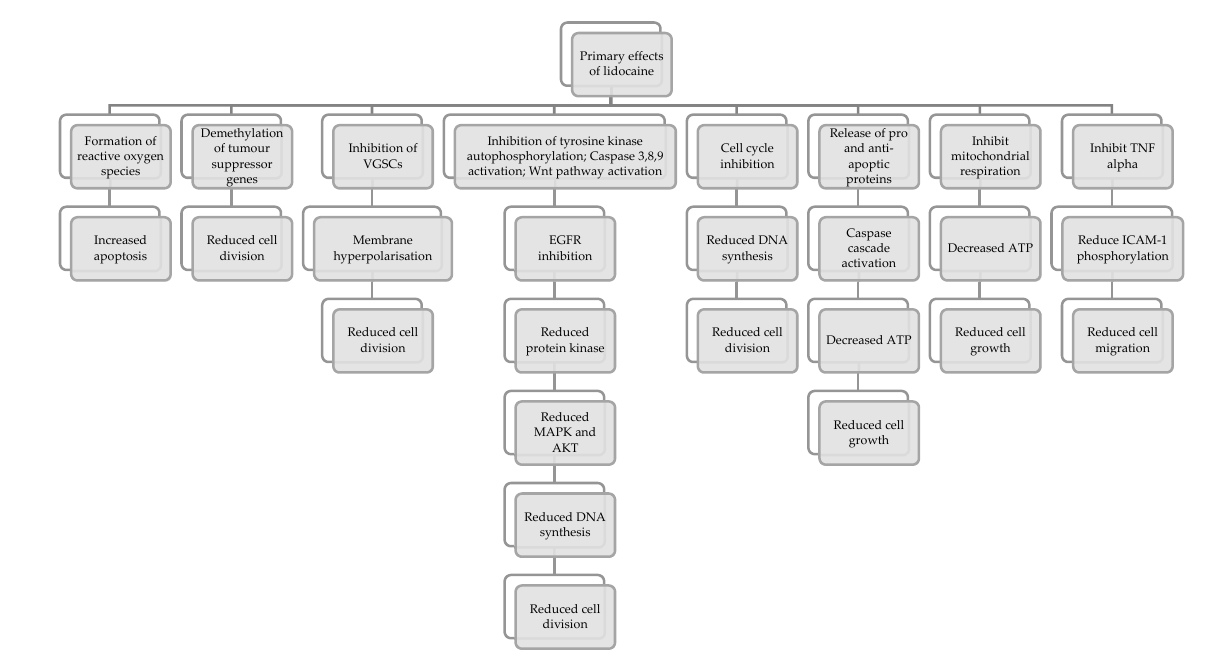
Figure 3. Indirect versus direct effects of local anaesthetics on tumour progression. Figure 4 below is a compilation of the vast array of mechanisms by which lidocaine exerts its effects on cancer cells.